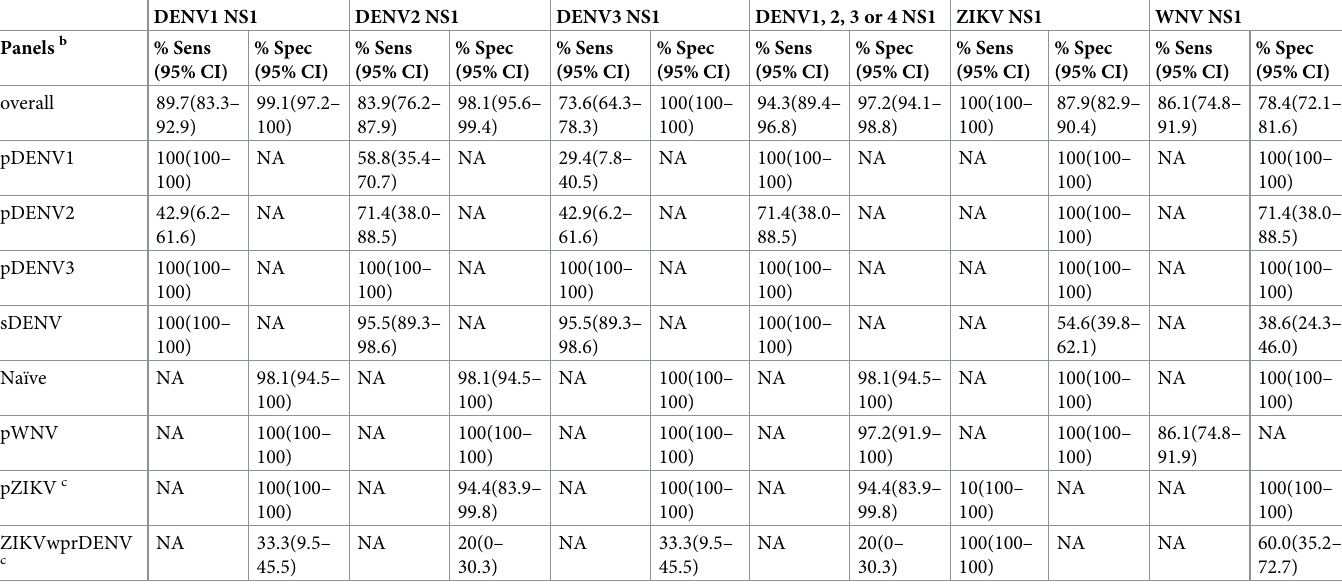
Table 2. Sensitivity and specificity of different NS1 IgG MIA a . DENV1